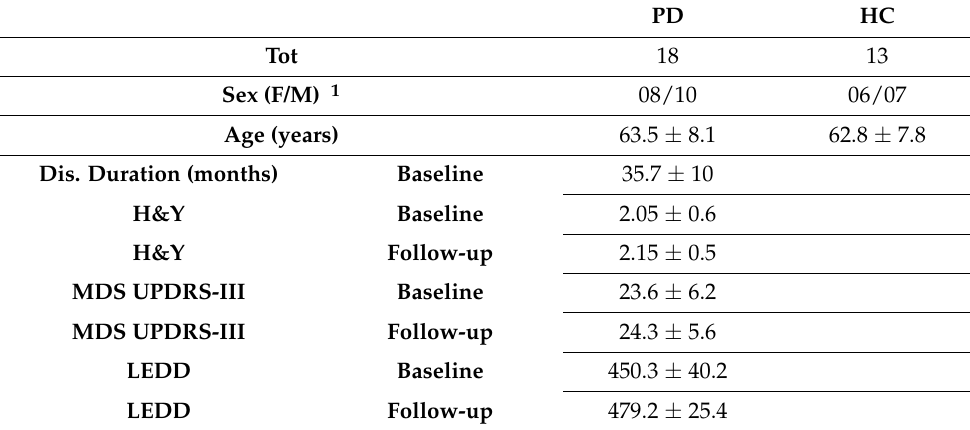
Table 1. Demographic and clinical data of our